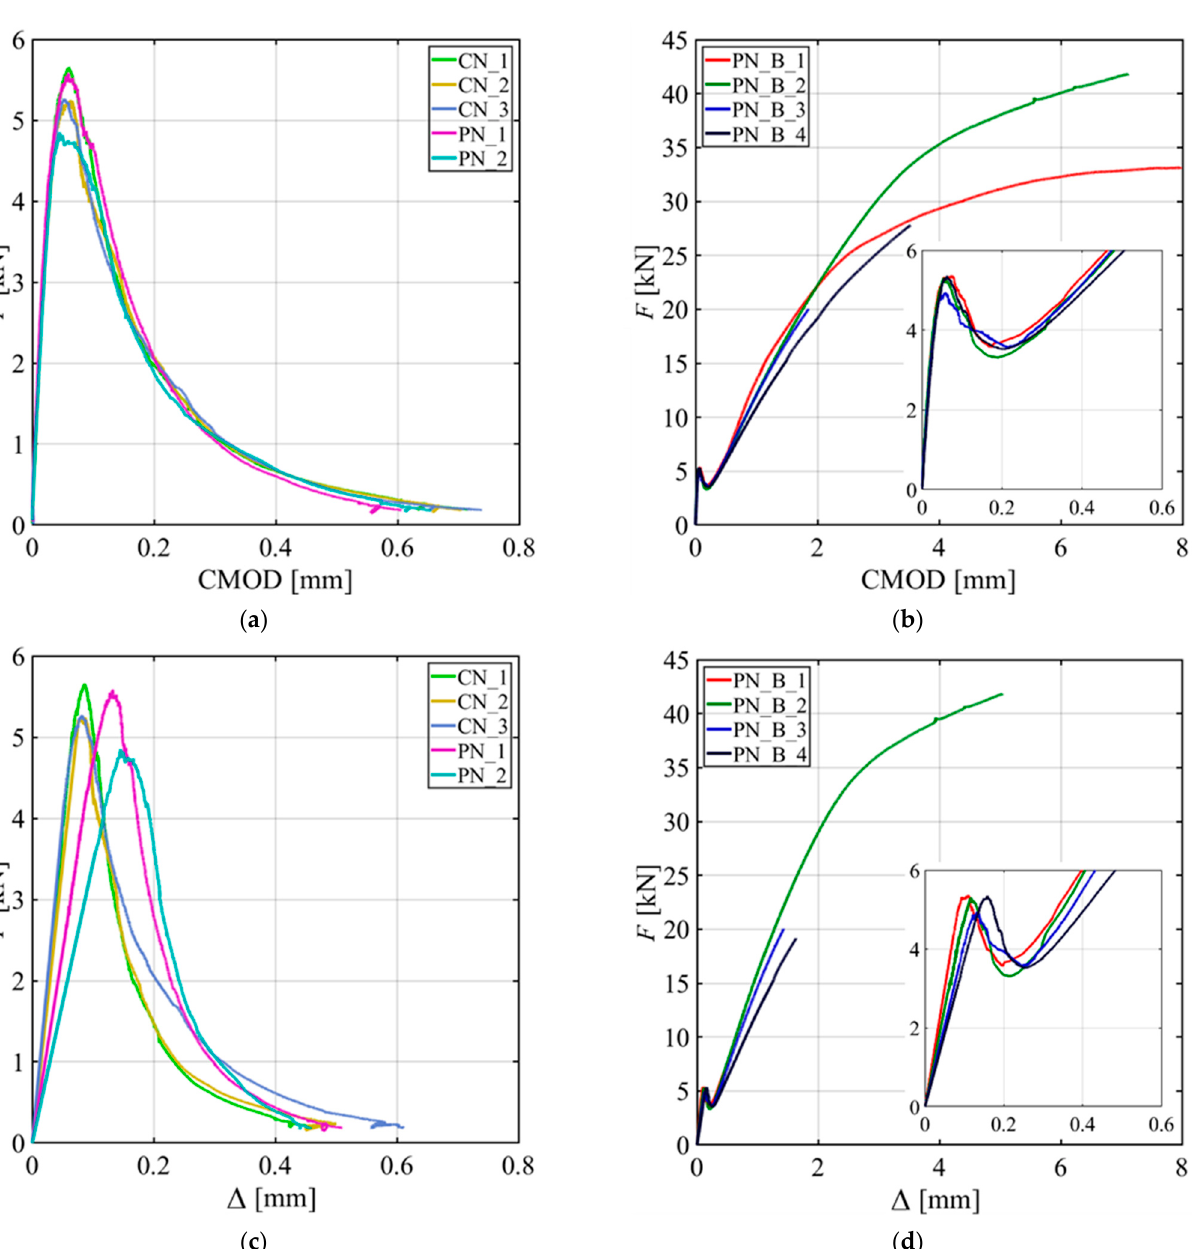
Figure 4. Load responses: ( a ) F -CMOD responses for CN_X and PN_X series specimens; ( b ) F -CMOD responses for PN_B_X series specimens with a call out for the first segment of the tests; ( c ) F - Δ responses for CN_X and PN_X series specimens; and ( d ) F - Δ responses for PN_B_X series specimens with a call out for the first segment of the tests.